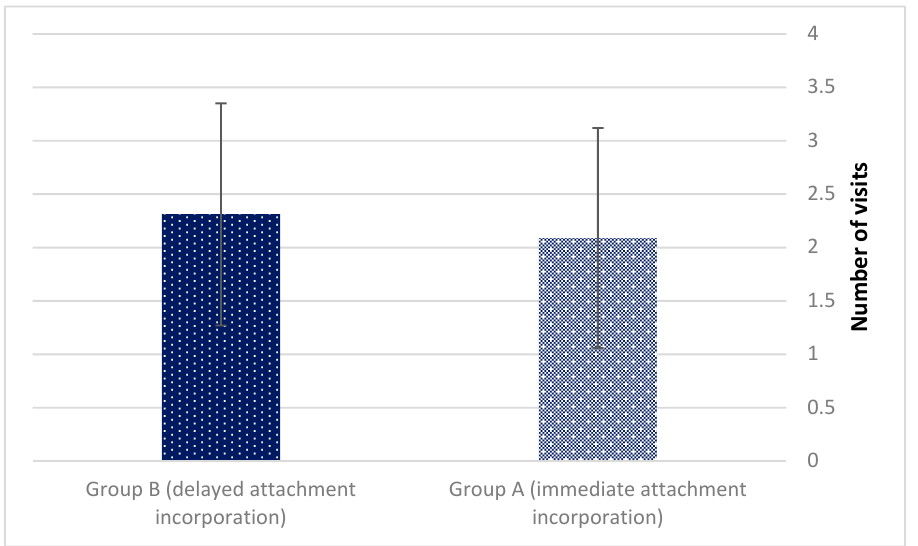
Figure 6. Liner exchange due to loss of retention (p = 0.487). The mean Gingival index also exhibited no statistically significant differences (1.3 ± 0.3 vs. 1.03 ± 0.2, p = 0.653) (Figure 7).